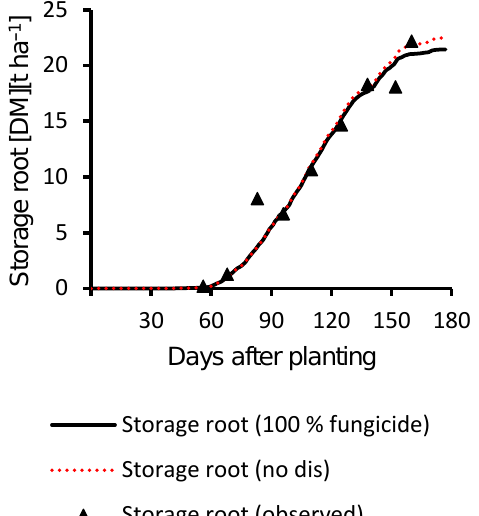
Figure 4. Simulated and observed values (2016: 100% fungicide) with Cercospora leaf spot ratings included in the simulation results: ( a ) leaf area index (LAI); ( b ) top weight (DM t ha −1 ) for the calibration treatment with sugar beet growth simulated with current genetics and without Cercospora leaf spot disease ratings being included in the simulation process as “no dis” treatment.